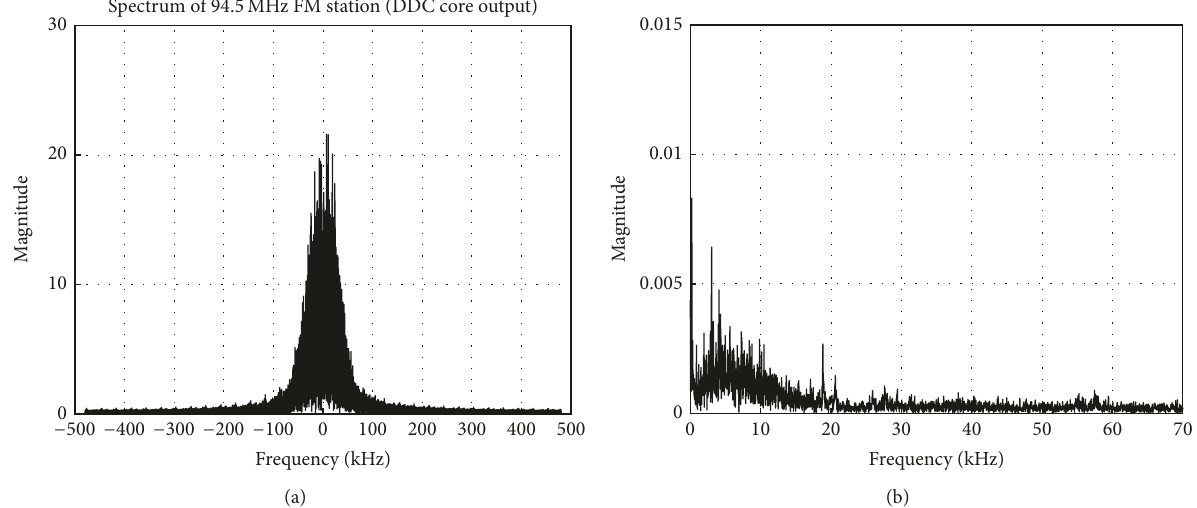
Figure 29: The results of FM receiver when tuning to 94.5 MHz radio station. (a) Spectrum of 94.5 MHz FM station baseband signal which is the output of a DDC core, (b) spectrum of FM-demodulated 94.5 MHz FM station in Matlab; the signal is real-valued after